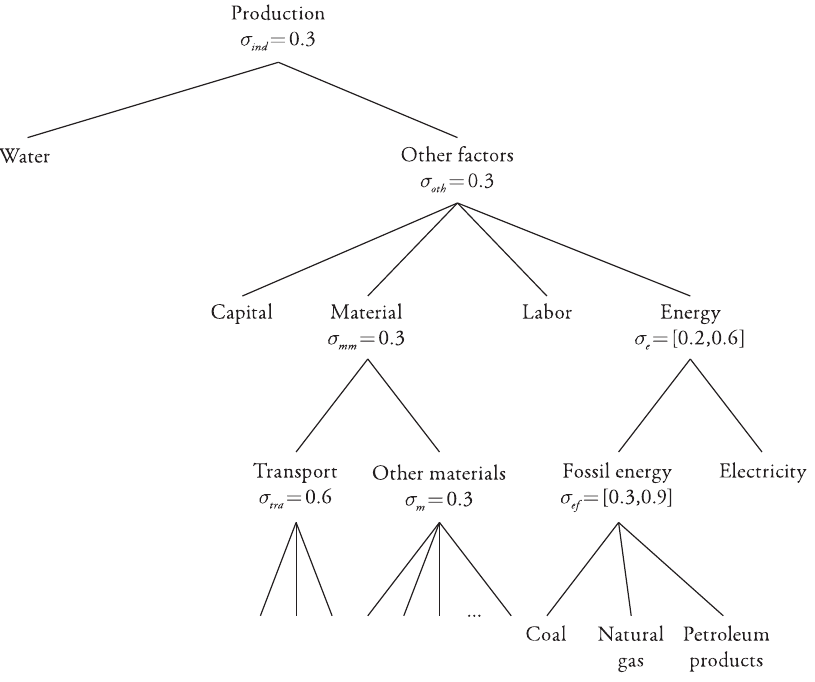
Figure 1: Nested CES Production Structure oflndustrial and Service Sectors Production